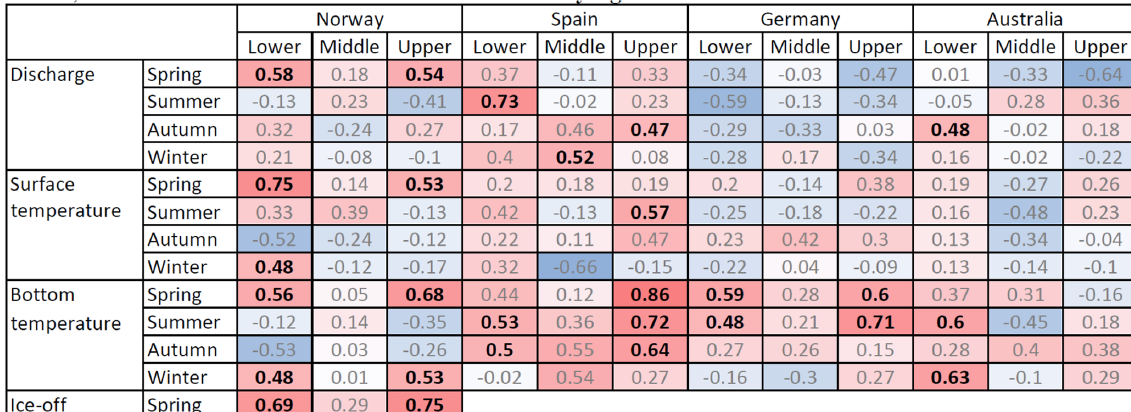
Table 5. ROCSS original for each combination of season, variable and tercile of lake hindcasts (Lake_F). Colour scale ranges from dark blue (ROCSS =− 1, perfectly bad forecast) to dark red (ROCSS = 1, perfect forecast), with white in the middle (ROCSS = 0, no change compared to reference forecast). Windows of opportunity are highlighted by bold, black numbers, i.e. a combination of season, variable and tercile associated with a statistically significant ROCSS value.